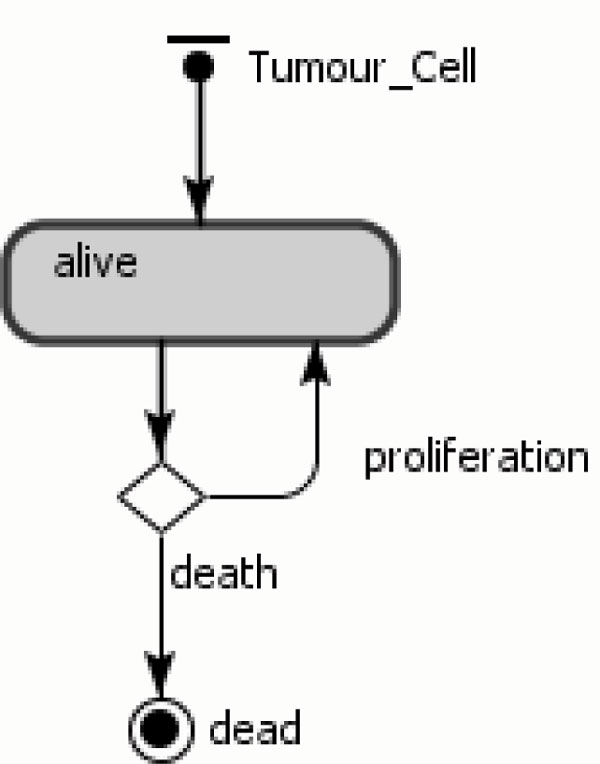
Tumour cell agent.